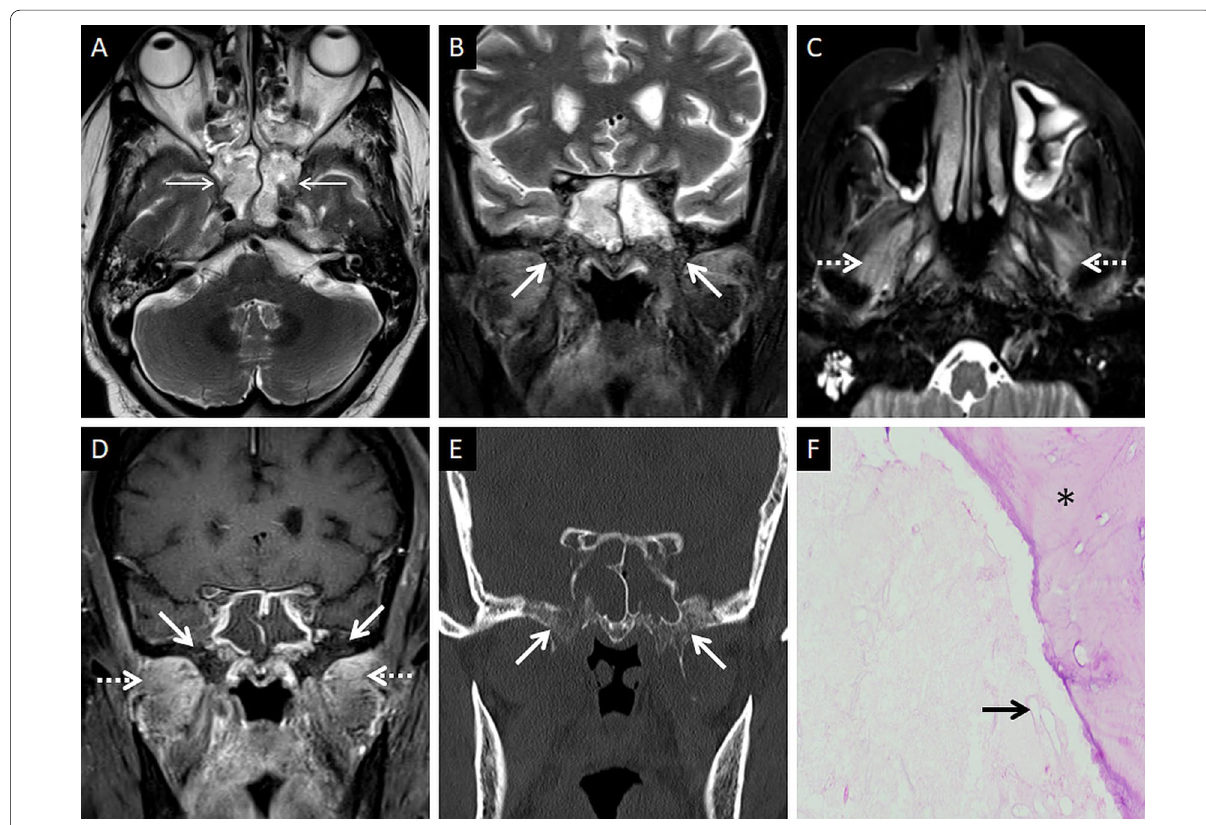
Fig. 11 SBO in ROCM. Axial T2W image of the brain ( a ) reveals bilateral sphenoid sinusitis (thin arrows). Coronal T2-FS image of the neck ( b ) demonstrates abnormal hyperintense marrow signals along the base of the sphenoid sinus and the greater wings of the sphenoid bone (thick arrows). Axial T2-FS image ( c ) shows oedematous swelling of the muscles of mastication (dotted arrows). CE FS coronal T1W image ( d ) demonstrates subtle abnormal marrow enhancement within the sphenoid bones (thick arrows) along with intense enhancement of the muscles of mastication (dotted arrows). Coronal CT image ( e ), using bone algorithm, confirms rarefaction of the sphenoid bones (thick arrow). Post-operative histopathology analysis ( f ), using HE staining, confirms Mucorales hyphae (thick arrow) with bone devitalisation and necrosis of the sphenoid